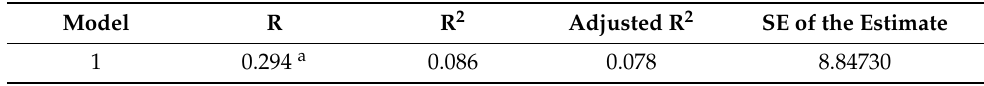
Table 4. R 2 results in this